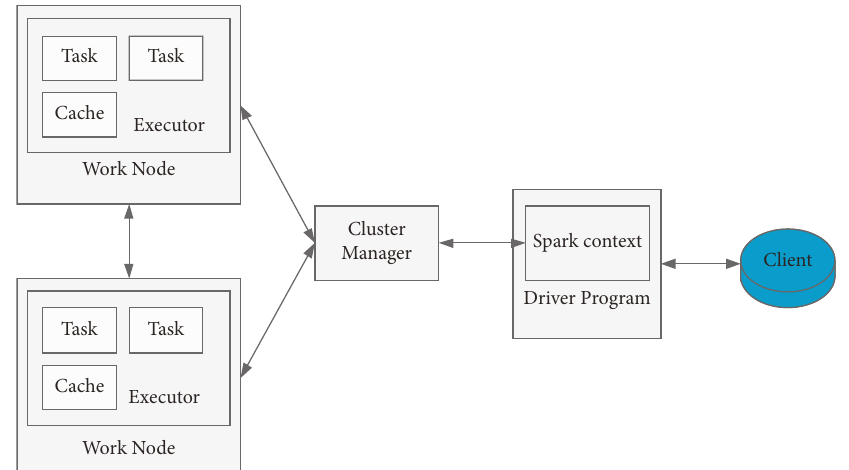
Figure 3: Spark execution